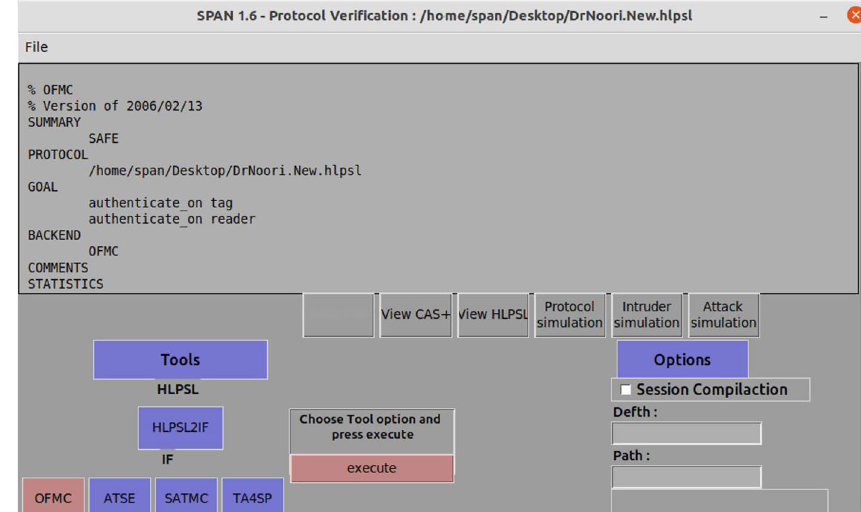
Fig. 9 Output of the proposed protocol using